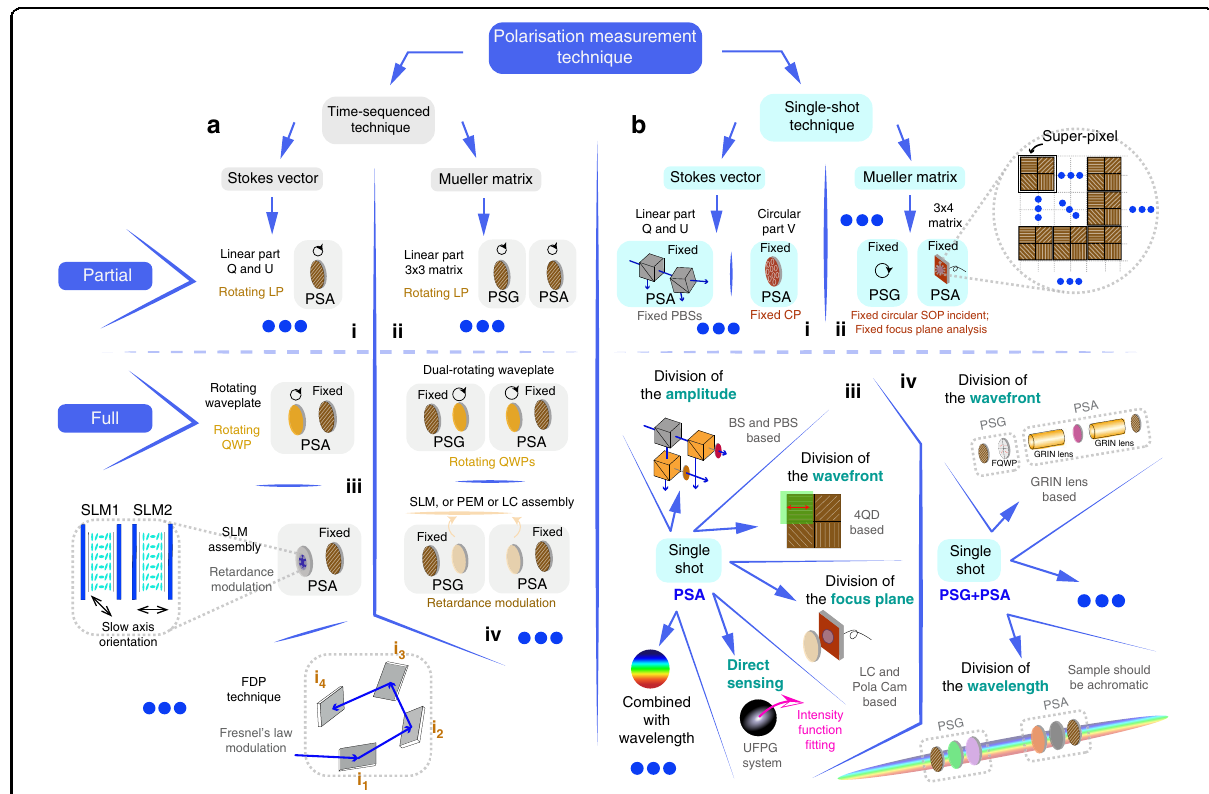
Fig. 3 Time-sequenced and single-shot polarisation measurement techniques. a Time-sequenced techniques: (i) Partial Stokes vector polarimetry; the PSA can be a rotating polariser. (ii) Partial MM polarimetry; the PSG and PSA can both be a rotating polariser. (iii) Full Stokes vector polarimetry; the PSA and PSG can both be a tuneable retarder (rotating quarter waveplate or SLM assembly) followed by a fi xed polariser 28,63,79 . (iv) Full MM polarimetry; the PSG can be a fi xed polariser followed by a tuneable retarder 28,63,79 (rotating quarter waveplate or LC components); the PSA can be a tuneable retarder (rotating quarter waveplate or LC components) followed by a fi xed polariser 28,63,79 . b Snap-shot techniques: (i) Partial Stokes vector polarimetry; the PSA can be a fi xed PBS assembly or circular polariser. (ii) Partial MM polarimetry; the PSA can be a fi xed polariser array 32 . (iii) Full Stokes vector polarimetry; the types consist of division of the amplitude 97 – 99 , division of the wavefront 71,100 – 105 , division of the focus plane 106 – 122 , and so on. (iv) Full MM polarimetry; the types consist of division of wavefront 72 , division of the wavelength 67,96 , and so on. (LP: linear polariser; QWP: quarter waveplate; FDP: four-detector photopolarimeter; for more information about such Fresnel ’ s law based polarimetry refer to ref. 288 ; BS: beam splitter; PBS: polarisation beam splitter; CP: circular polariser; FQD: four quadrant detector; FQWP: four quadrant waveplate;